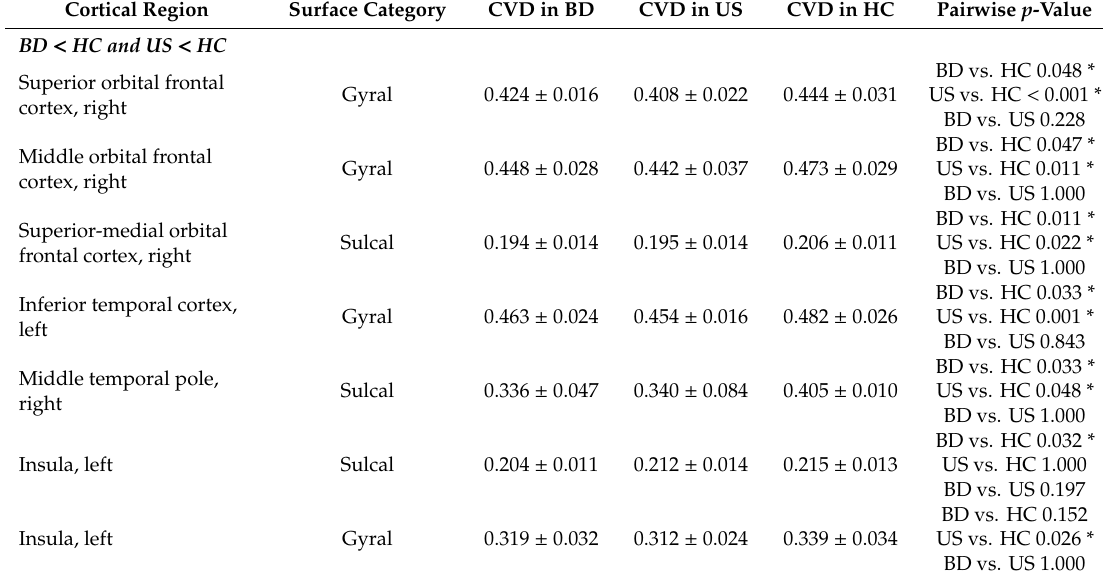
Table 2. Significant di ff erence of curvedness (CVD) values in both BD patients and una ff ected siblings, compared with healthy